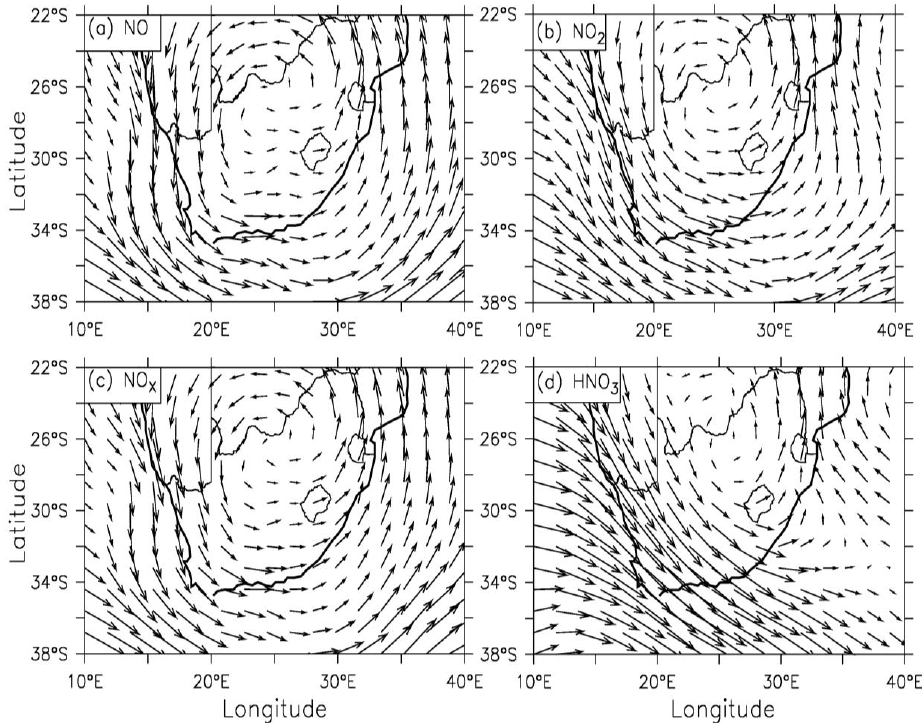
Figure 13 The composite of 700 hPa wind flow during extreme events of pollutants (NO, NO 2 , Fig. 13. The composite of 700hPa wind flow during extreme events of pollutants (NO, NO 2 , NO x and HNO 3 ) concentration at surface in Cape NO x and HNO 3 ) concentration at surface in Cape Town.